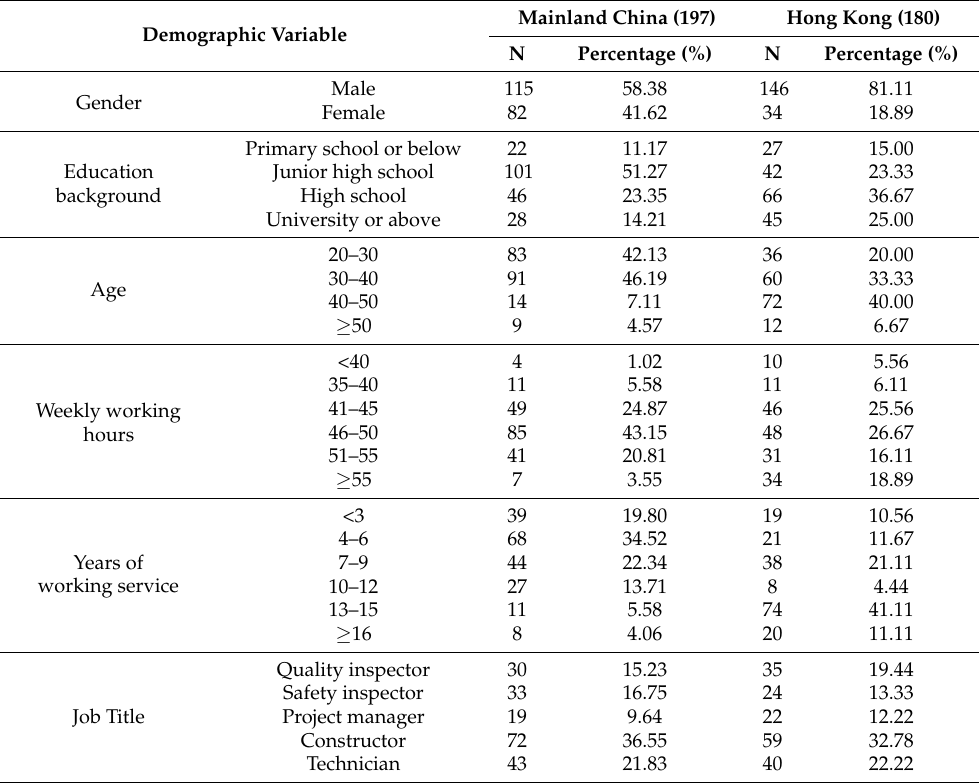
Table 2. Demographic information of respondents from Mainland China and Hong Kong.